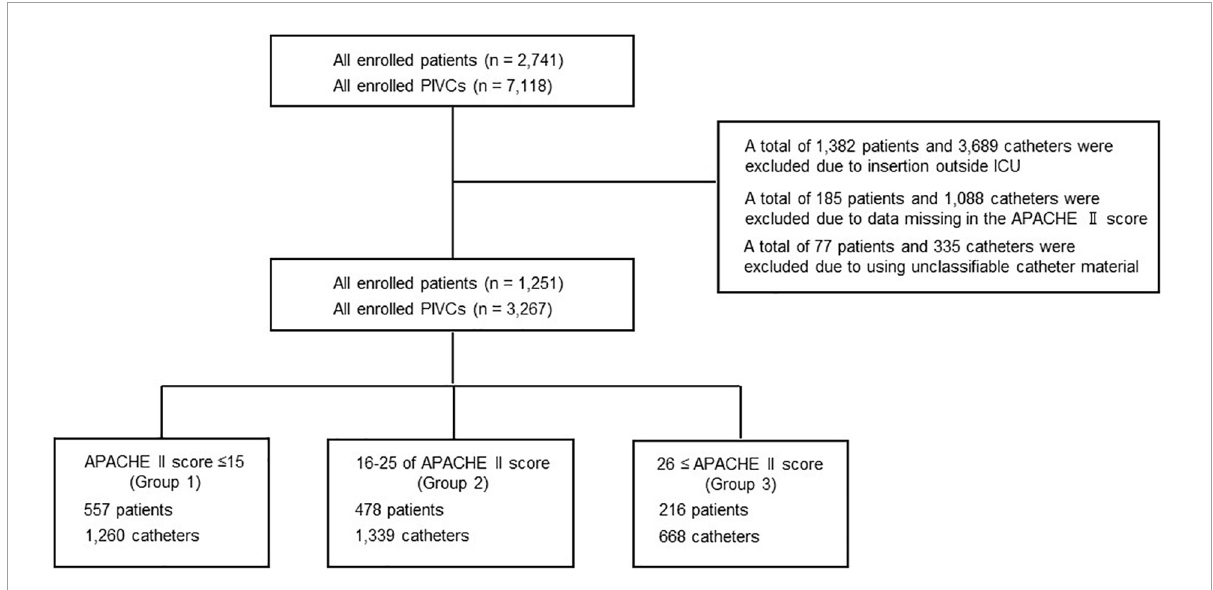
FIGURE1 Flowchart depicting the screening and enrolment process within the study. APACHE, acute physiology and chronic health evaluation; ICU, intensive care unit; PIVC, peripheral intravascular